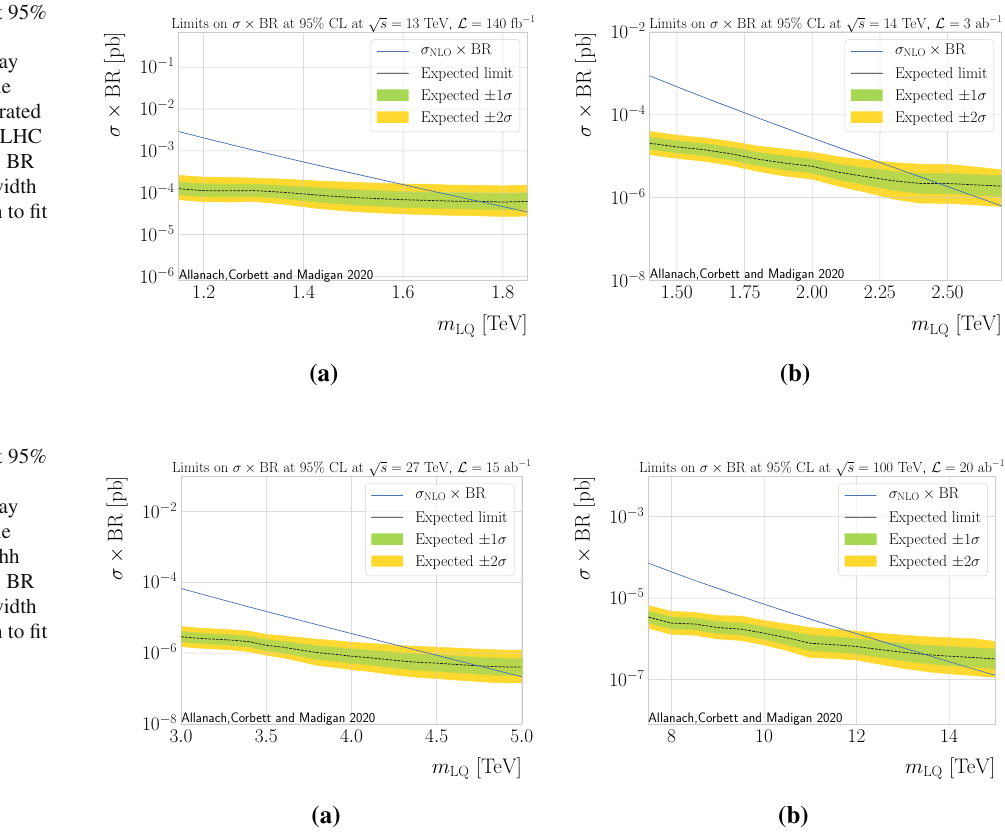
Fig. 13 Expected limits at 95% CL on σ × BR for the pair production of LQs and decay into a μμ jj final state at the LHC with full Run II integrated luminosity ( a ) and the HL-LHC ( b ). Theory curves σ NLO × BR are calculated for narrow width LQs with couplings chosen to fit